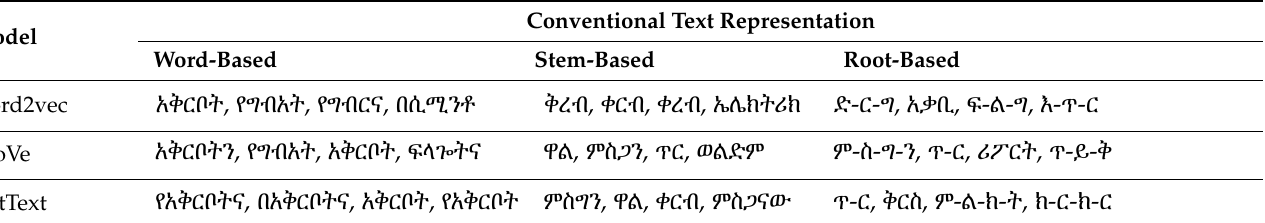
Table 12. Effectiveness of Amharic retrieval with and without query expansion. Precision Technique ndgc